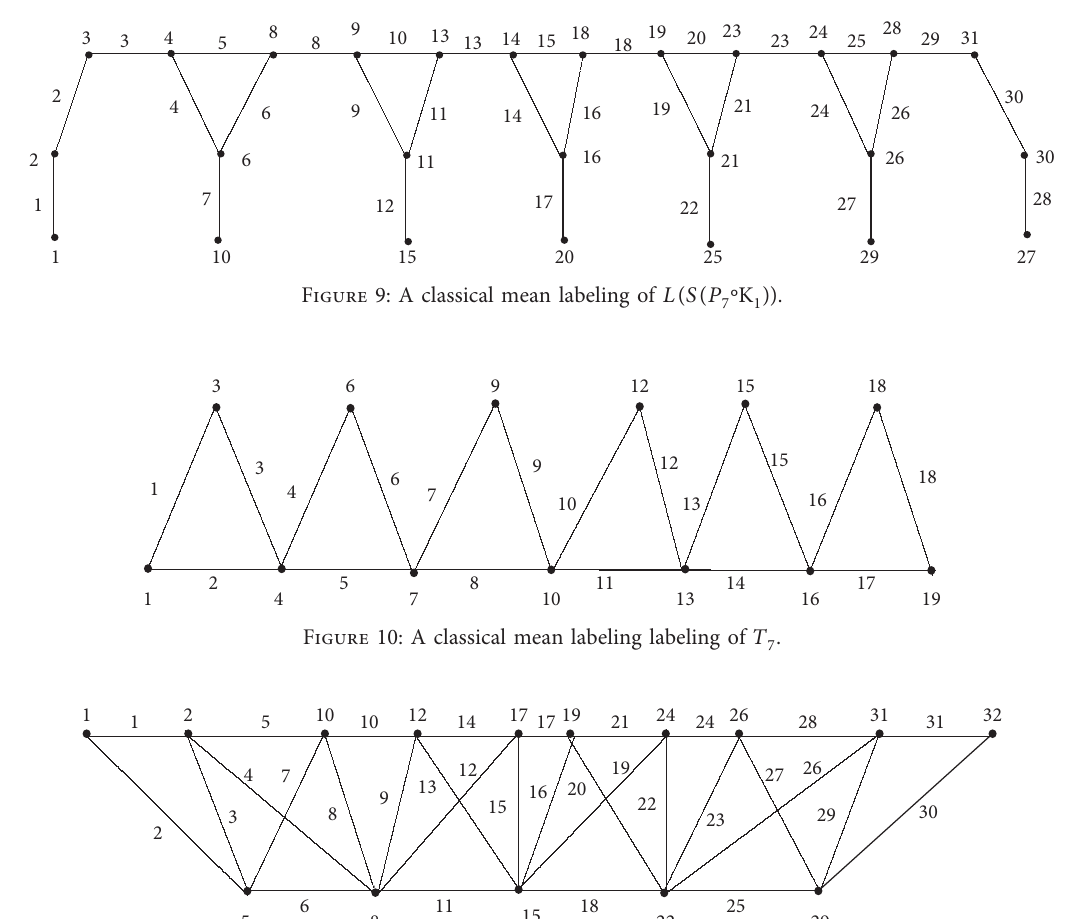
) is given by Figure 8. K 6 ° 1